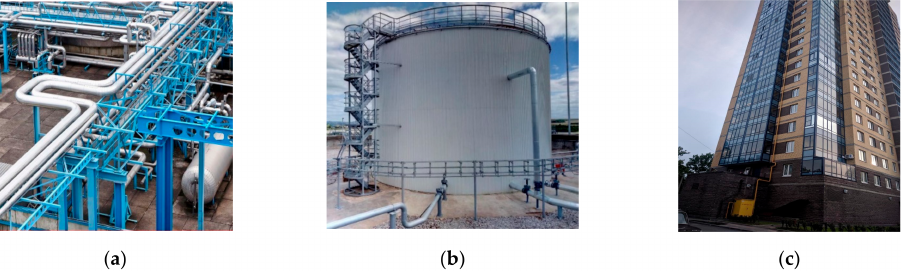
Figure 2. ( a ) Pipeline overpasses and metal structures; ( b ) Reservoirs; ( c ) Gas pipeline to roof boiler room. Copyrighted by